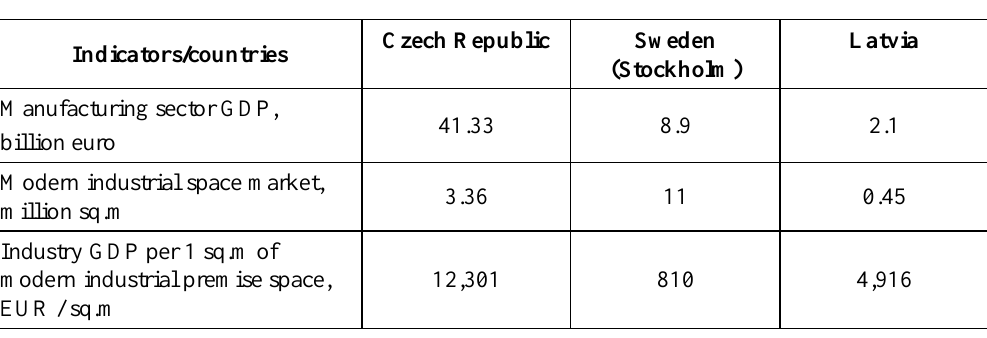
Table 2. The results of complex calculations of the Latvian industry’s productivity and development of modern industrial premises scenarios, year 2009 in 2005 prices [calculations and presentation made by